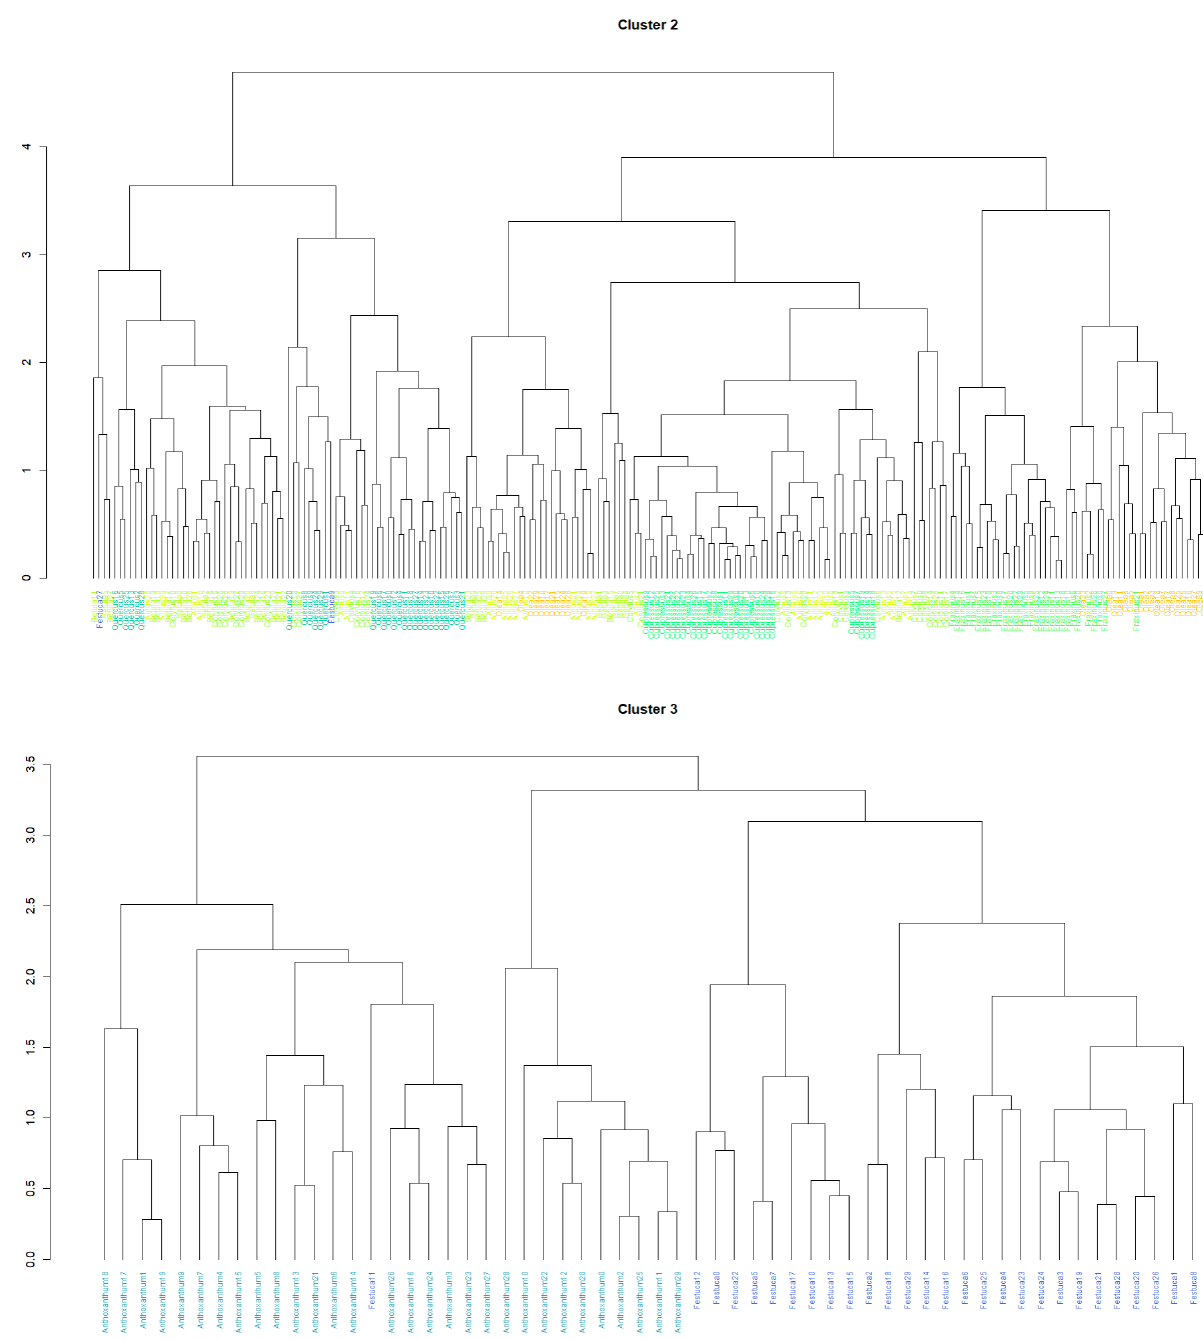
Figure 5. Dendrogram of the size based hierarchical clustering. The first panel shows the overall dendrogram with the 3 obtained clusters. The 3 other panels represent excerpts and zoom into each of the 3 clusters. Note that pollen measurements were coloured from red to blue in the ascending order of diameter, as provided by the supplier.